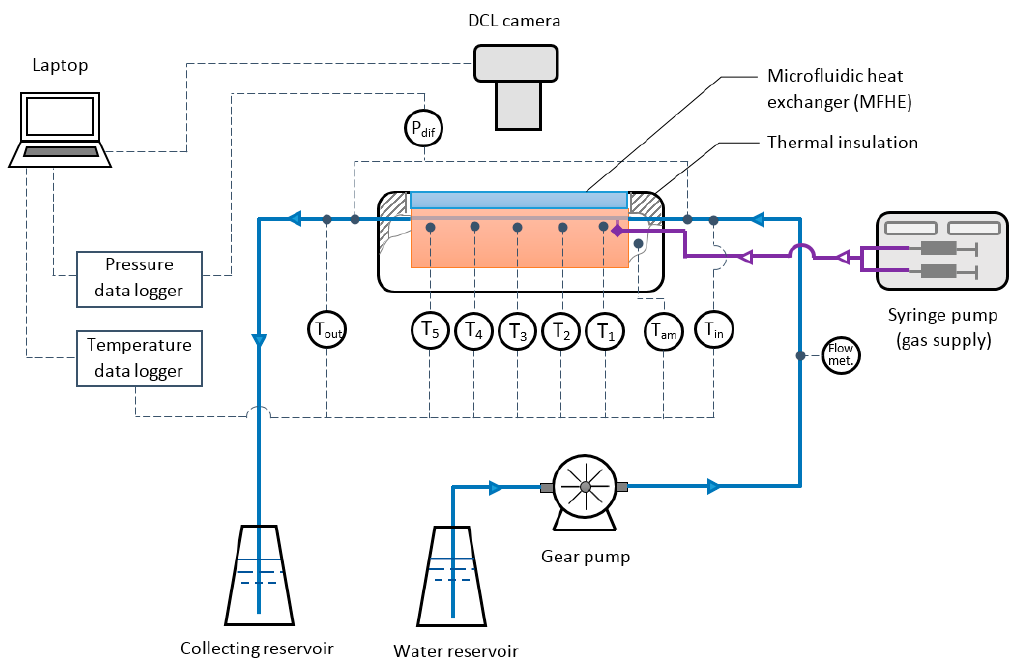
Figure 2. Schematic diagram of the experimental setup to study hydrodynamics and heat transfer in single- and two-phase flow in microfluidic heat exchanger (MFHE).